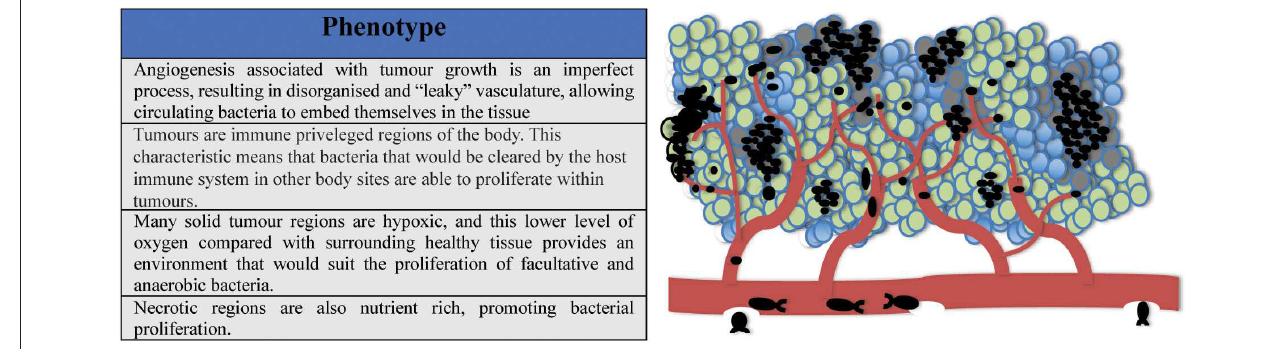
FIGURE 2 | Tumors are uniquely hospitable environments for bacteria. (i) Leaky vasculature allows circulating bacteria to embed in tumor tissue; (ii) Tumors are immune privileged regions; (iii) Solid tumors possess low oxygen regions suitable for the proliferation of facultative and anaerobic bacteria; (iv) High-turnover regions of tumors can be nutrient rich, promoting bacterial